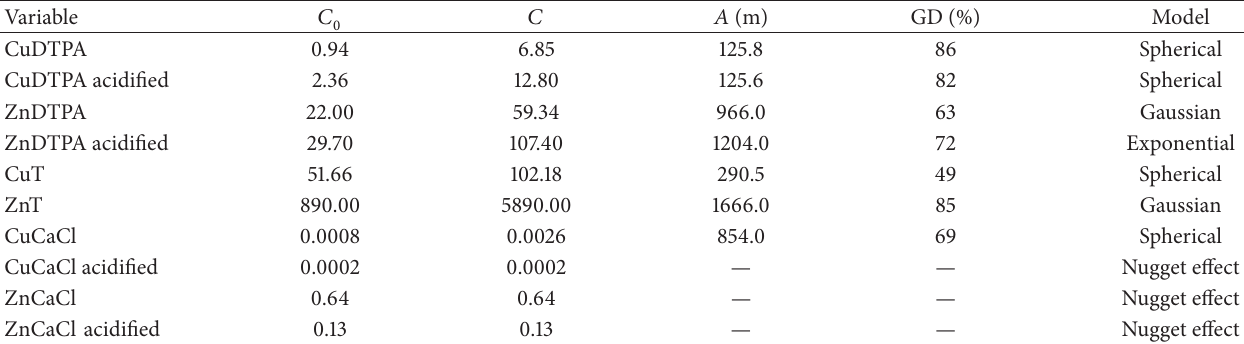
Figure 3: Spatial distributions of the Cu and Zn extracted by DTPA and CaCl 2 in natural and acidified samples and the total content of Cu and Zn in natural soil samples. (a) and (c) Cu and Zn extracted by DTPA in natural samples; (b) and (d) Cu and Zn extracted by DTPA in acidified soil samples; (e) and (f) total content of Cu and Zn in soil; (g) Cu extracted by CaCl 2 in natural samples. Table 6: Semivariograms parameters for spatial distributions of Cu and Zn in soils from a vineyard region of S˜ao Paulo state: nugget effect ( 𝐶 0 ), sill ( 𝐶 ), range ( 𝐴 ), and dependency degree (GD).